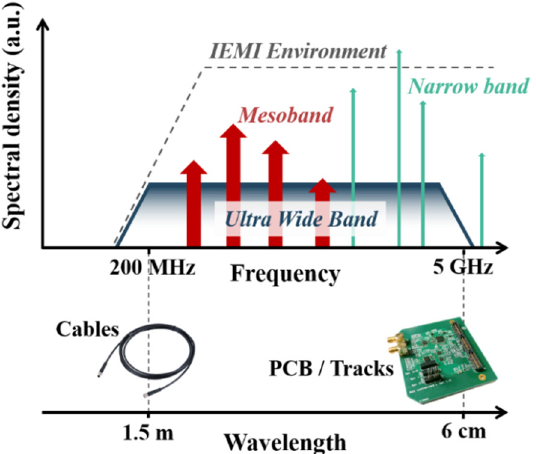
Figure 1. Relationship between the IEMI frequency range and its equivalent wavelength range in accordance with potential target’s scale.